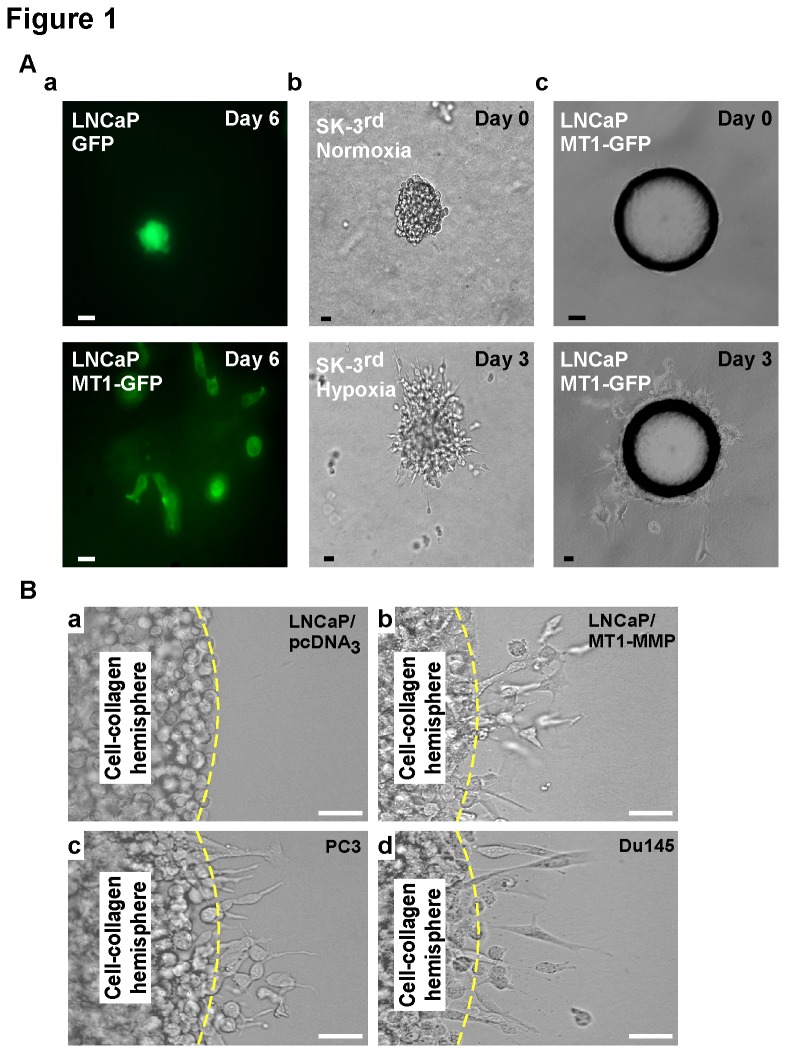
Cell scattering assays for monitoring cell invasive ability.A) a. Single-cell scattering assay: Single, isolated LNCaP cells were mixed with collagen and examined daily. MT1-GFP-expressing cells gradually displayed a scattering growth pattern after 6 days in culture as compared to the aggregated growth of GFP-expressing cells. b. Aggregate scattering assay: SK-3rd cells were cultured for 12 days to form mammospheres, transferred and embedded in collagen, and then cultured under normoxia or hypoxia. A scattered pattern was seen after 3 days under hypoxia. c. Microcarrier bead scattering assay: MT1-GFP expressing LNCaP cells were cultured with beads for 24 hours, then transferred and embedded into collagen. Invaded cells were seen as a scattered pattern at day 3. Scale bars = 20 μm. B) Assessment of cancer cell invasiveness using novel 3-D invasion assay: LNCaP cells expressing vector control (a) or MT1-MMP (b), human prostate cancer PC3 cells (c), and Du145 cells (d) were suspended in collagen, dotted into the well of a 96-well plate, and covered with collagen followed by media. After 18-h incubation, PC3 and Du145, as well as MT1-MMP expressing LNCaP cells, showed increased numbers of invaded cells as compared to LNCaP vector control cells. Scale bar = 50 μm.